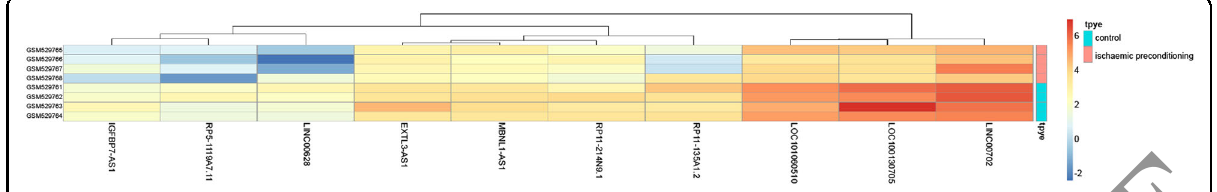
Fig. 1 Heatmap of differentially expressed lncRNAs plotted according to the GSE21164 microarray dataset from the GEO database. GEO Gene Expression Omnibus, lncRNA long noncoding RNA